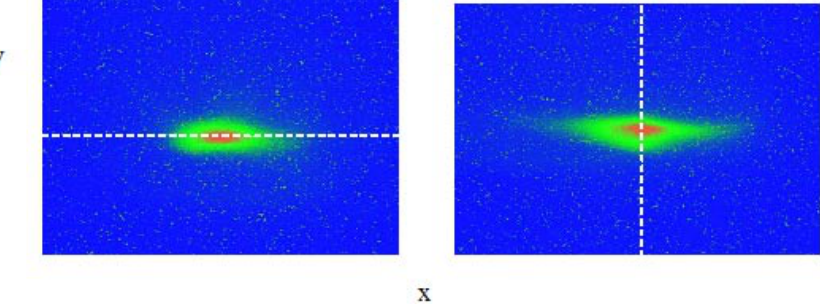
fits.FIG. 9. (Color) Beam images at a horizontal minimum (left) and a vertical minimum (right) showing the horizontal and vertical lines where scans were